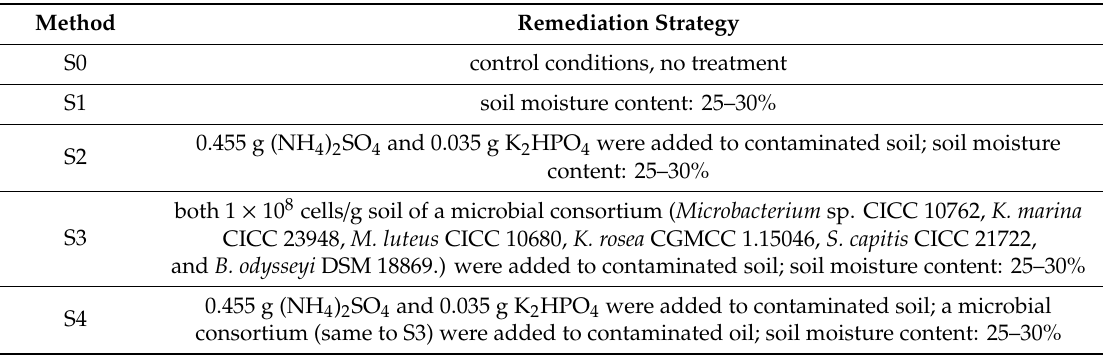
Table 2. Di ff erent remediation strategies for PH-contaminated